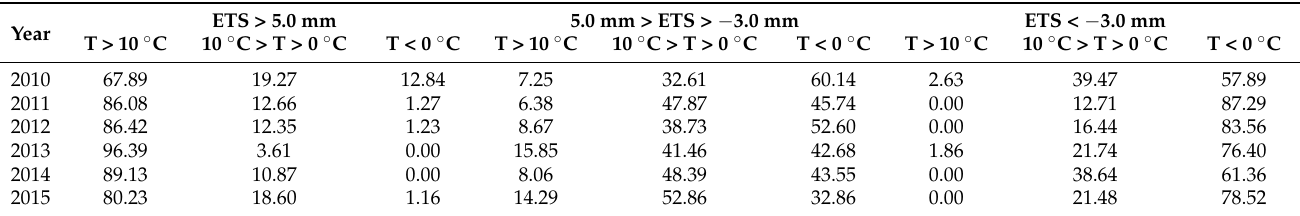
Table 7. Statistics of displacements and maximum temperatures